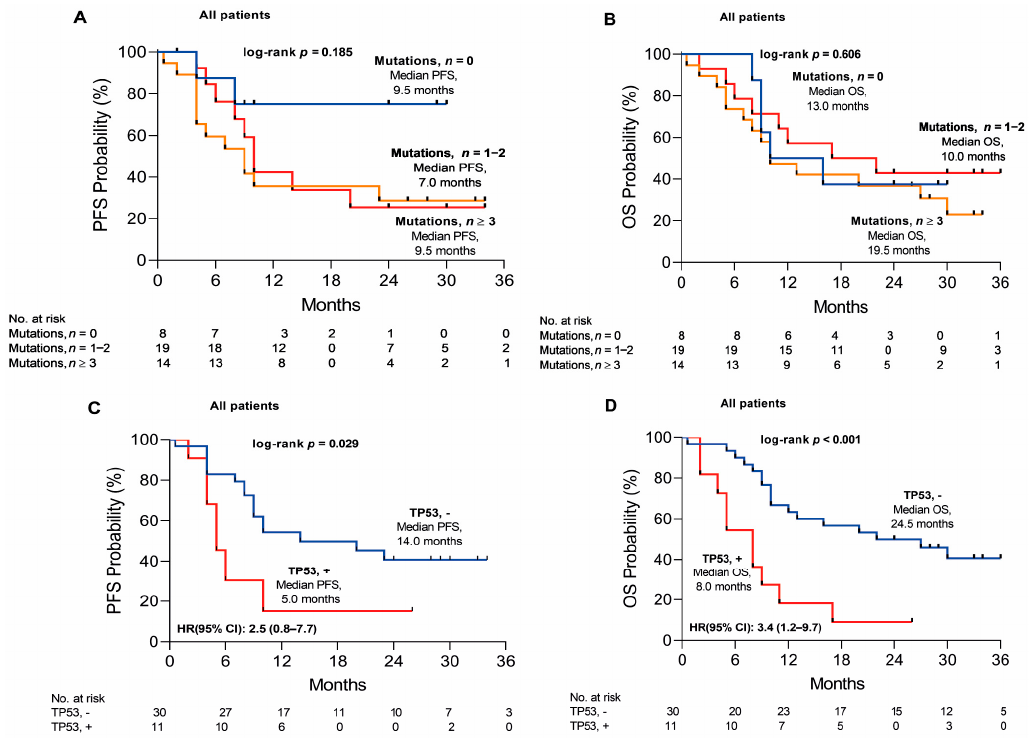
Figure 4. Kaplan–Meier estimates of progression–free and overall survival. ( A , B ) Patients categorized according to mutation count with 0, 1–2, and ≥ 3 mutations; mutation count is color-coded in blue—0, in orange—1 − 2 and in red— ≥ 3 mutations. ( C , D ) Estimates according to mutant TP53 status; blue color indicates negative TP53 status and red—positive.